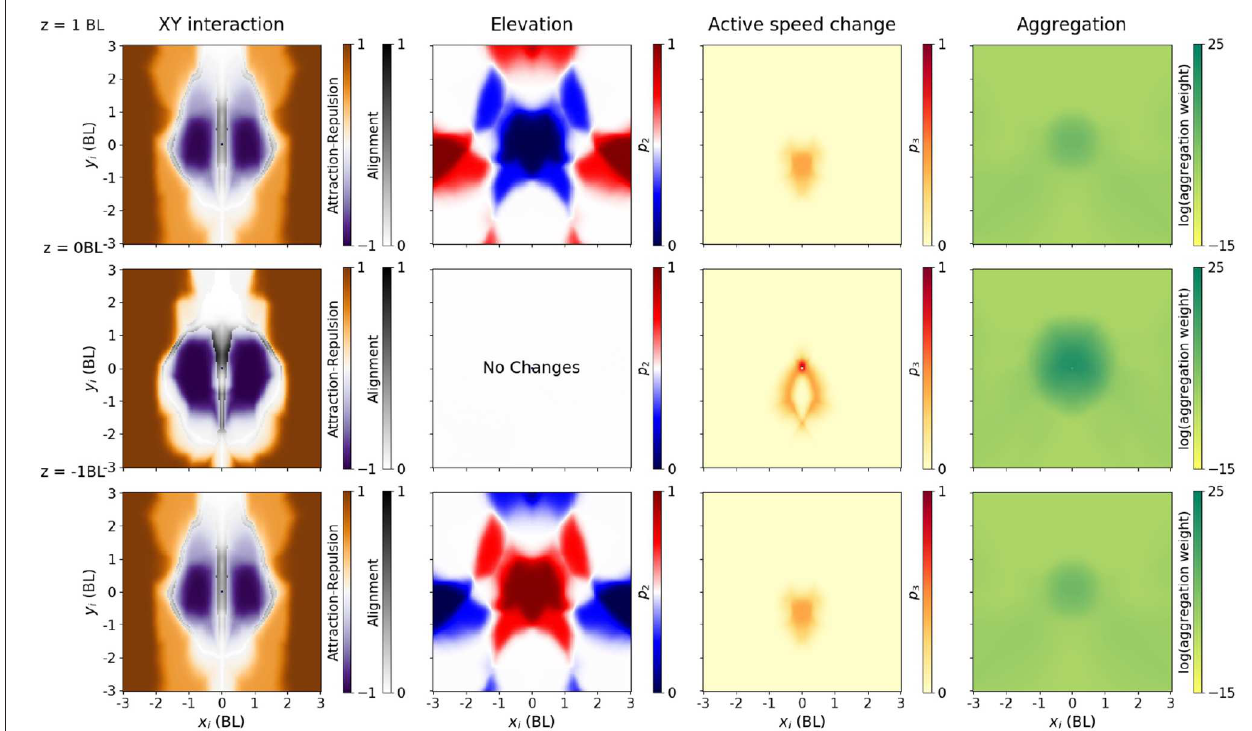
FIGURE 5 | Policy producing a rotating ball, as a function of neighbor relative location. Each output (three from the pair-interaction, one from the aggregation) is shown in a different column. All columns have three diagrams, with the neighbor 1 BL above (top row), in the same XY plane (middle row) and 1 BL below the focal (bottom row). Speed of both the focal and neighbor has been fixed to the median in each configuration. In addition, in columns 2–4, we plot the average with respect to an uniform distribution over all possible relative neighbor orientations (from − π to π ). First column: Interaction in the XY plane (change of azimuth). Instead of plotting p 1 , we explain interaction using the approximate notions of alignment (gray), attraction (orange), and repulsion (purple) areas, as in [44]. Alignment score (gray) measures how much the azimuth changes when changing the neighbor orientation angle, and it is computed only in the orientation areas (see Methods, Section 2.5). Attraction (orange) and repulsion scores (purple) measure how much the azimuth change when averaging across all relative orientation angles, and we plot it only outside orientation areas. Second column: Elevation angle, through the mean value of the p 2 parameter. Blue areas indicate that the focal fish will move downwards ( p 2 < 0.5), while red areas indicate that the focal fish will move upwards ( p 2 > 0.5). Third column: Active change in speed, through the mean value of the p 3 parameter. Darker areas (large mean p 3 ) indicate increase in speed, and lighter areas indicate passive coast. Fourth column: Output of the aggregation module. Neighbors in the darker areas weight more in the